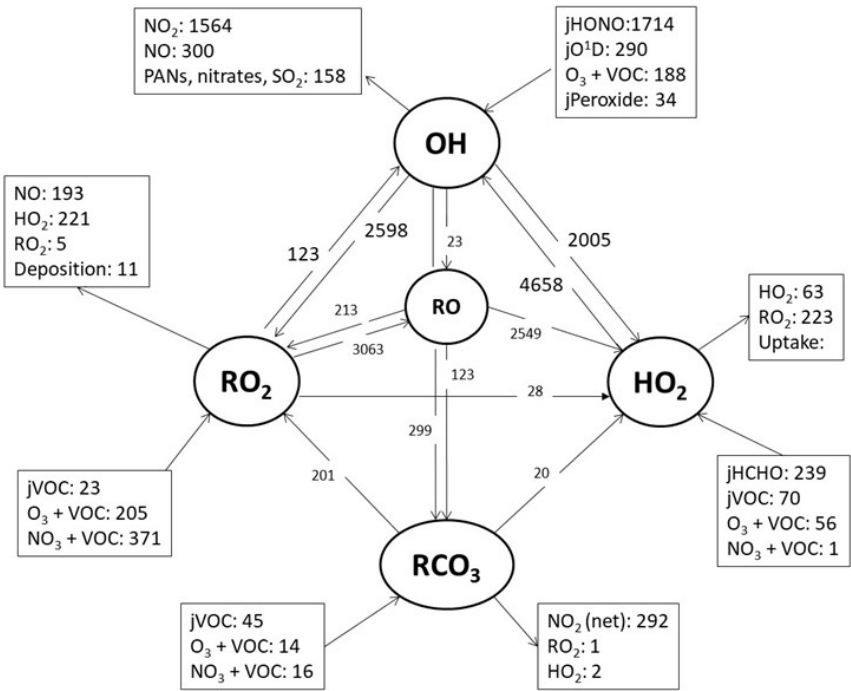
Figure 9. A model reaction flux analysis, showing the mean rate of reaction for formation, propagation and termination of radicals (pptvh − 1 ) (day and night) during the whole